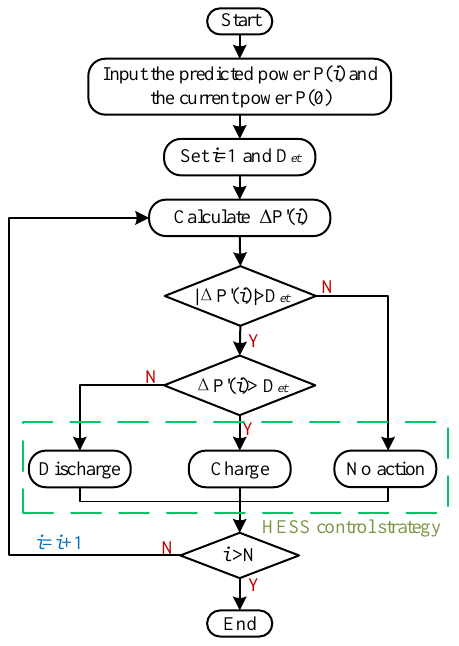
Figure 11. The flow of advanced smoothing control strategy.